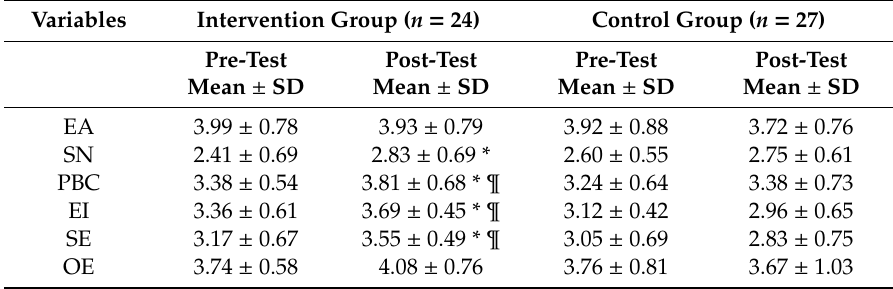
Table 3. Results of psychological indices between the two groups at baseline and follow-up.